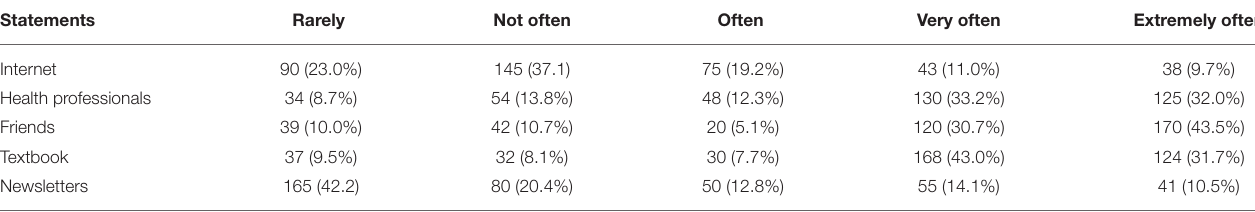
TABLE 5 | Attitudes toward seeking health information ( N = 391).